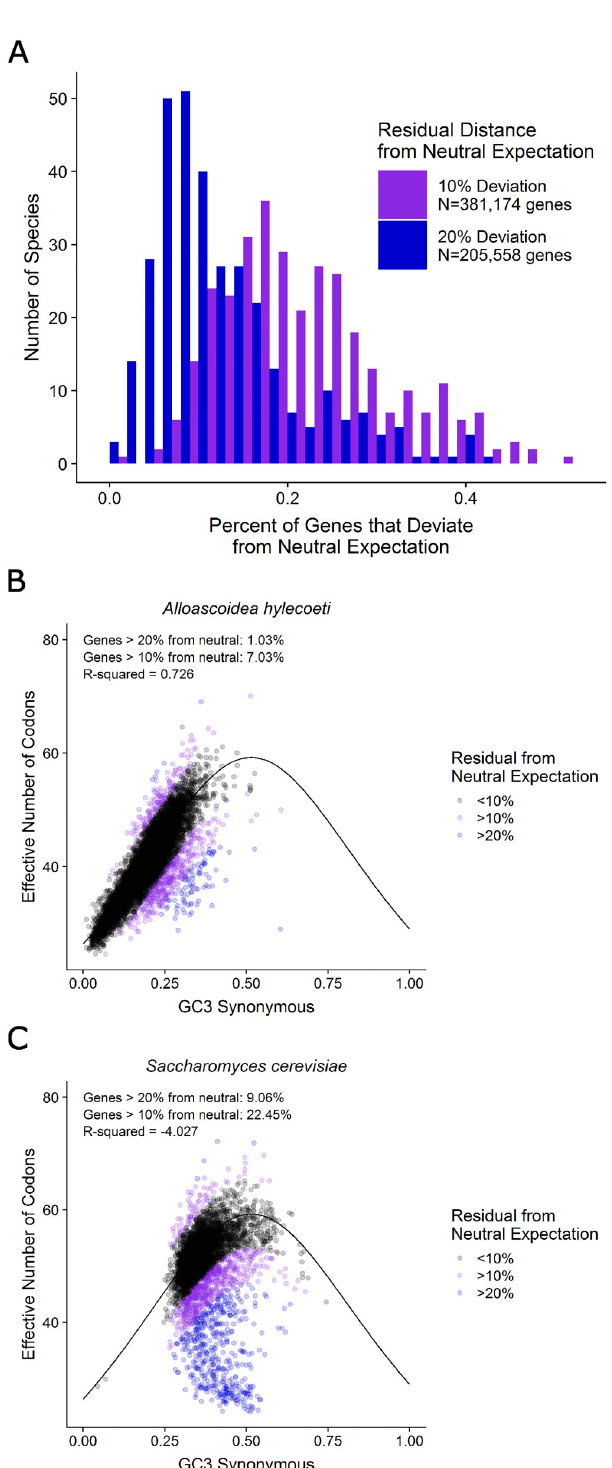
Fig 5. Comparison of the silent third position GC composition of the third codon position (GC3) suggests that individual codons vary in their fit to the neutral expectation (i.e., that codon usage is solely driven by GC mutational bias and genetic drift). The neutral expectations for the different codons were obtained from the models developed by Palidwor et al. (2010). A) Observed relative frequency of the alanine codon GCC (shown on the Y axis) plotted against GC3 (shown on the X axis) for each of the 327 budding yeast species analyzed in this study. The